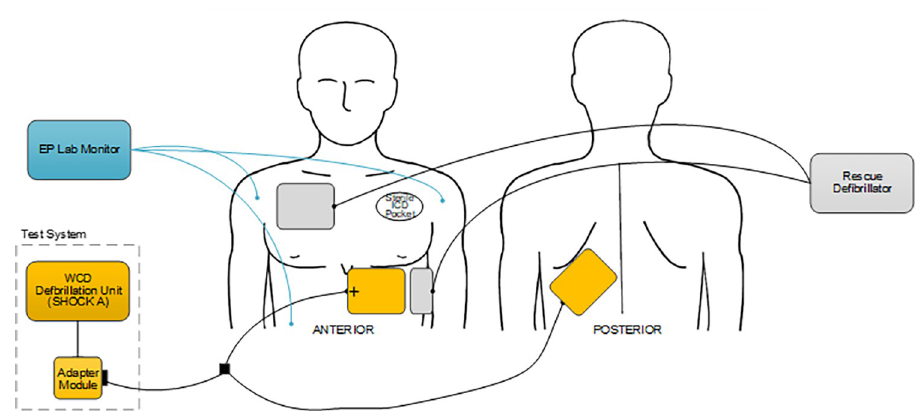
Fig 10. Human study experimental setup. Anterior and posterior views of the thorax for the human study of the 170J BTE waveform (SHOCK A) in the electrophysiology laboratory. The test system showing the WCD defibrillation unit and adapter module is shown in the lower left. Two sets of defibrillation patches are shown, with the test system connected to the yellow patches and rescue defibrillator connected to the gray patches. The test system pads (yellow) were applied in standard anterior and posterior positions, with the anterior pad in the left parasternal region and the posterior pad in the left infrascapular position. The rescue defibrillation pads (gray) were placed in the standard anterior-apical position on the subject’s torso for defibrillation from a commercially available external defibrillator. Surface ECG was monitored with electrophysiology laboratory recording equipment. WCD = wearable